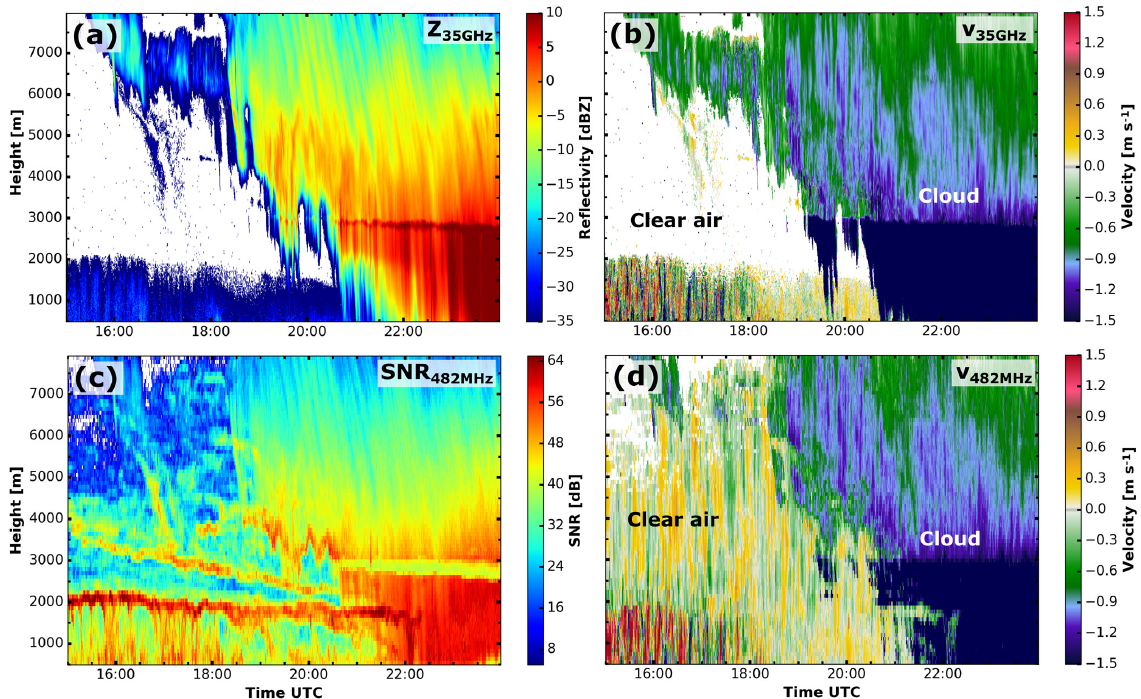
Figure 3. Cloud radar reflectivity (a) , RWP SNR (c) , cloud radar velocity (b) and RWP velocity (d) on 17 June 2015 illustrating the Bragg– Rayleigh ambiguity. As soon as the particle return dominates (high reflectivity in the cloud radar), the clear-air signal in the RWP is masked by the falling particles. This case is presented in more detail in Sect. 5.1.